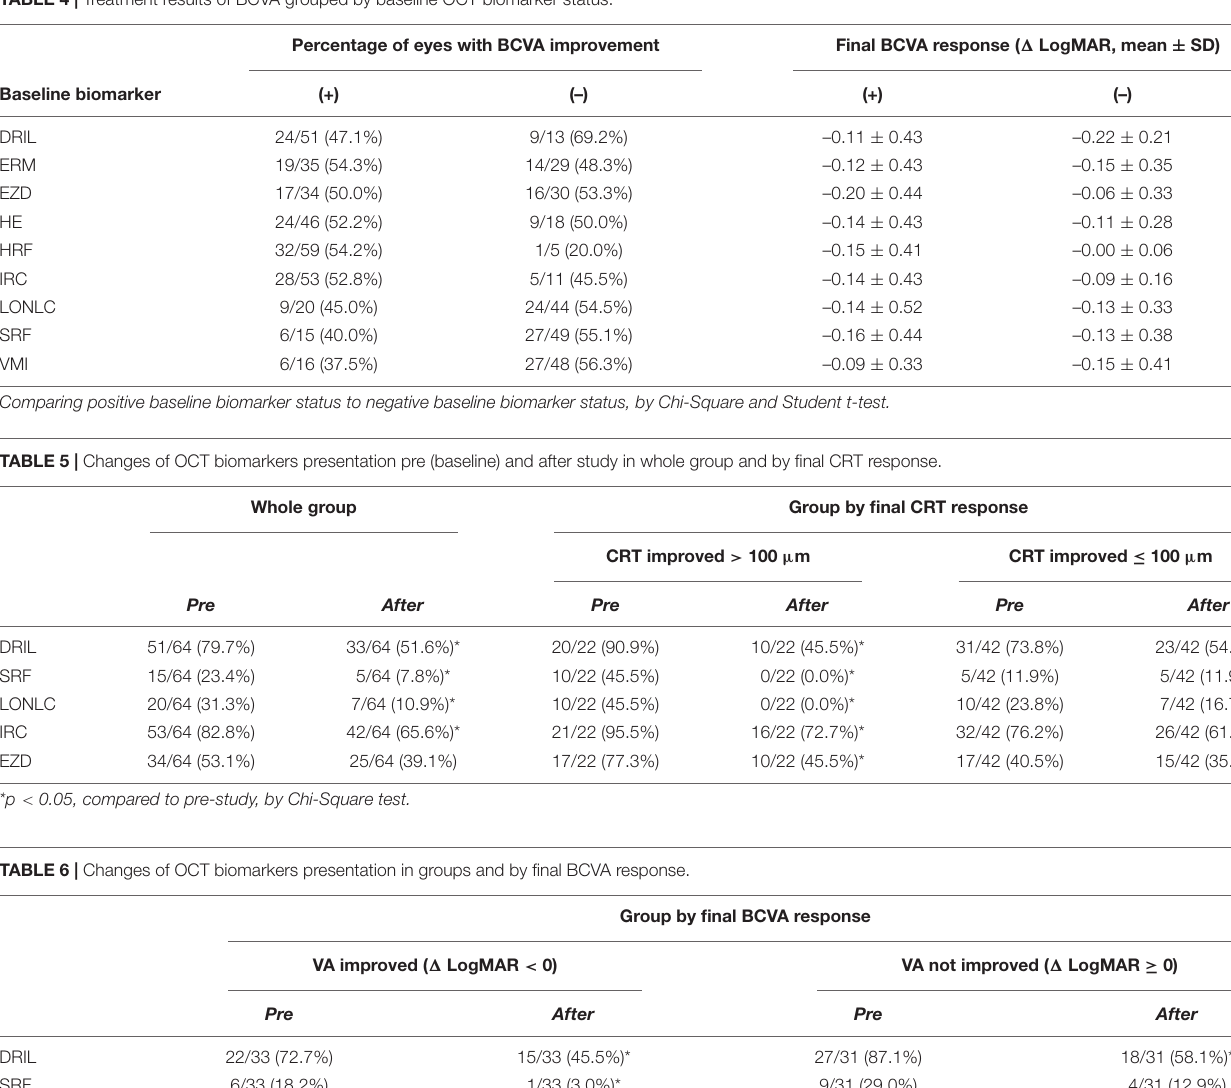
TABLE 4 | Treatment results of BCVA grouped by baseline OCT biomarker status.